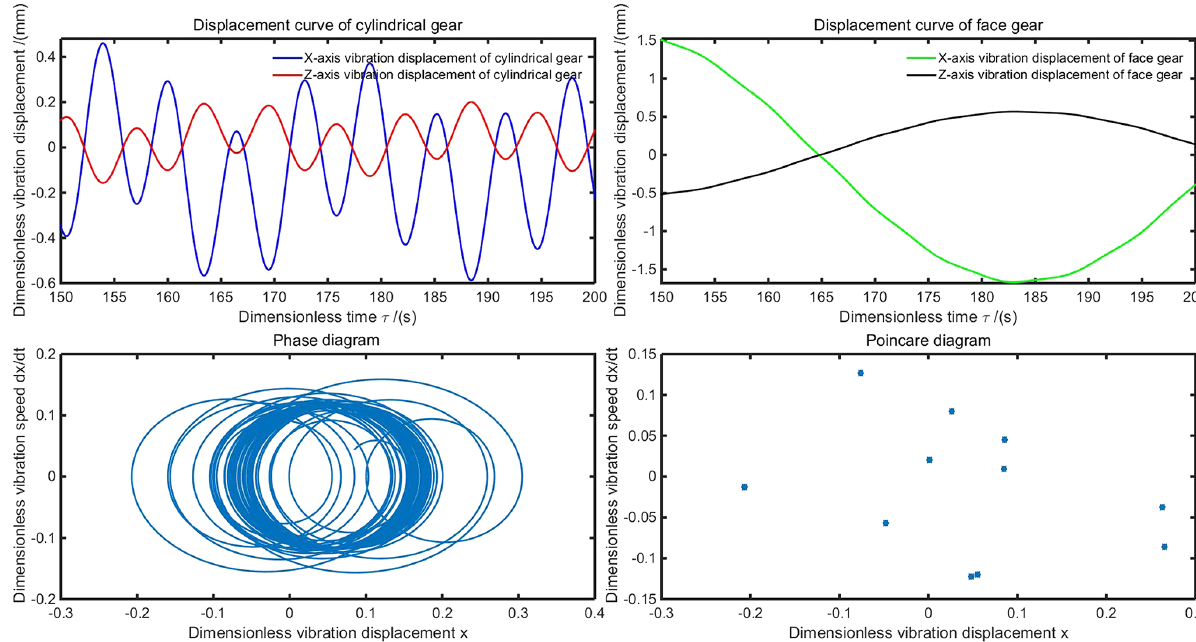
Figure 15. Displacement, phase, and Poincare diagrams of 1st stage face gear pair nonlinear system.